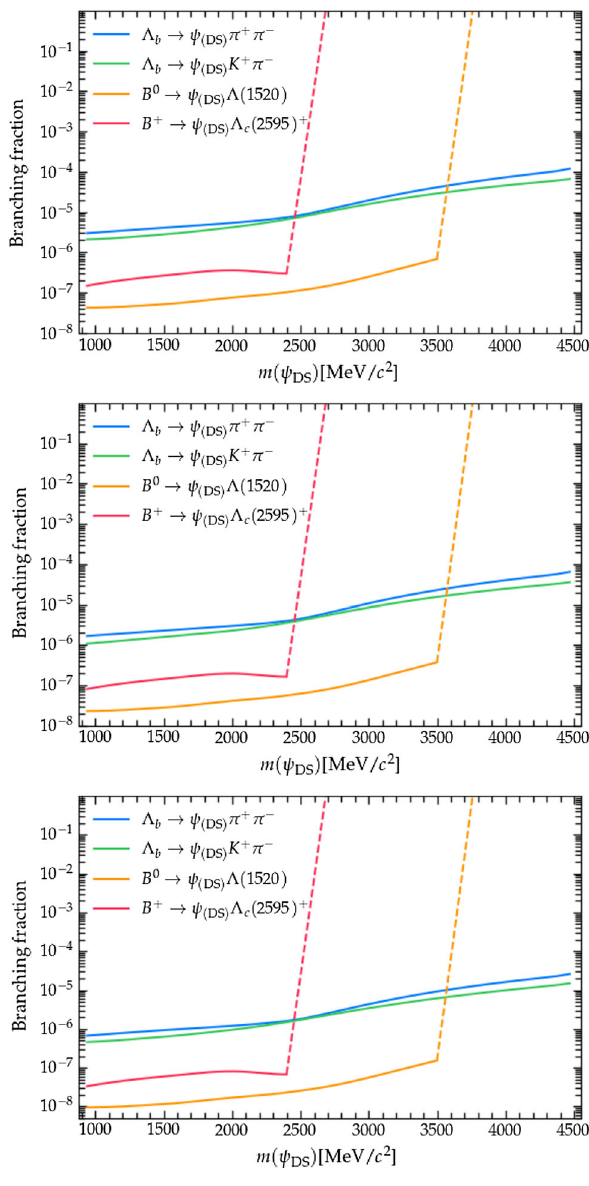
Fig. 5 Projected statistical sensitivity in terms of branching fractions excluded at 95% CL at, from top to bottom, 15 fb − 1 , 50 fb − 1 and 300 fb − 1 . All three curves were obtained by interpolation, having used an exponential extrapolation (dashed line) in the abrupt change of slope for the B decays in order to account for the detector’s inability to recon- struct neither the Λ( 1520 ) nor the Λ c ( 2595 ) + baryons at the limit of the phase space, i.e., whenever m ψ reaches the mass difference of the DS SM mother meson and daughter